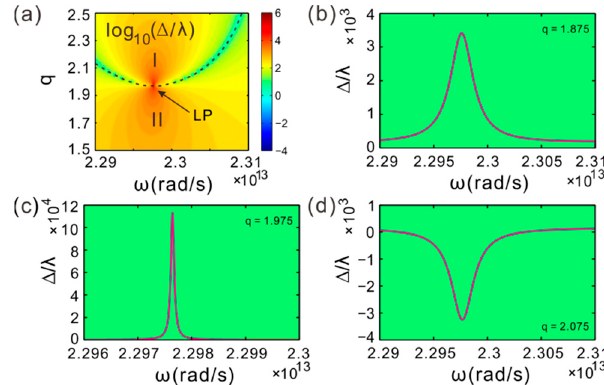
Figure 6. ( a ) The spatial Goos–Hänchen (GH) shift in the vicinity of CPA-LP 1 . The GH shift is negative in part I, while it is positive in part II. It has rescaled the result by taking logarithm log 10 | ∆ / λ | for clarity. ( b – d ) The spatial GH shift varying with the angular frequency for several given gain–loss factor q = 1.875, 1.975, and 2.075, respectively.